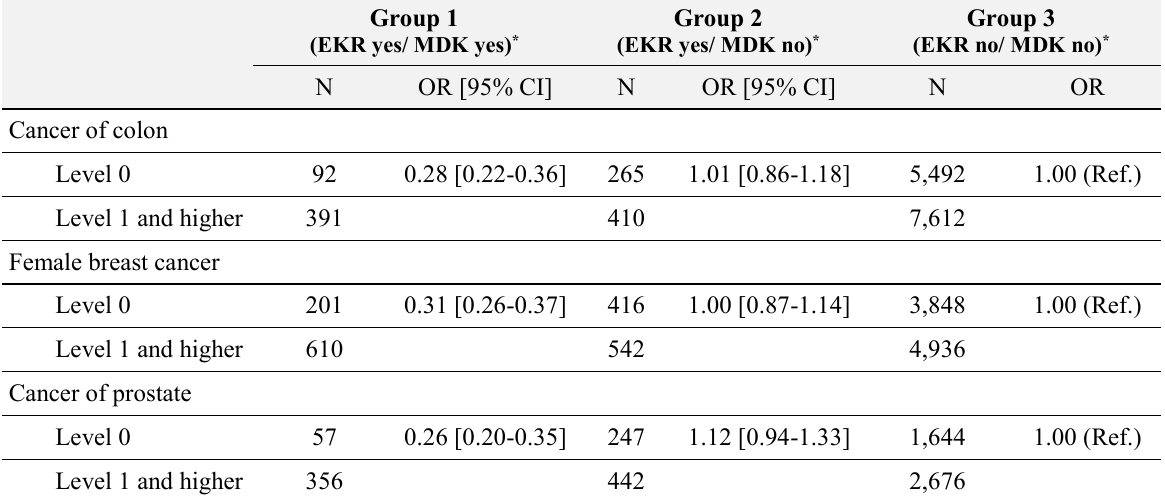
Table 4. Chance of receiving no nursing care support (Level 0) among MDK patients by type of cancer, adjusted for age (breast and prostate cancer) and for age and sex (colon cancer), by cancer case status in cancer registry (EKR) and MDK database Group